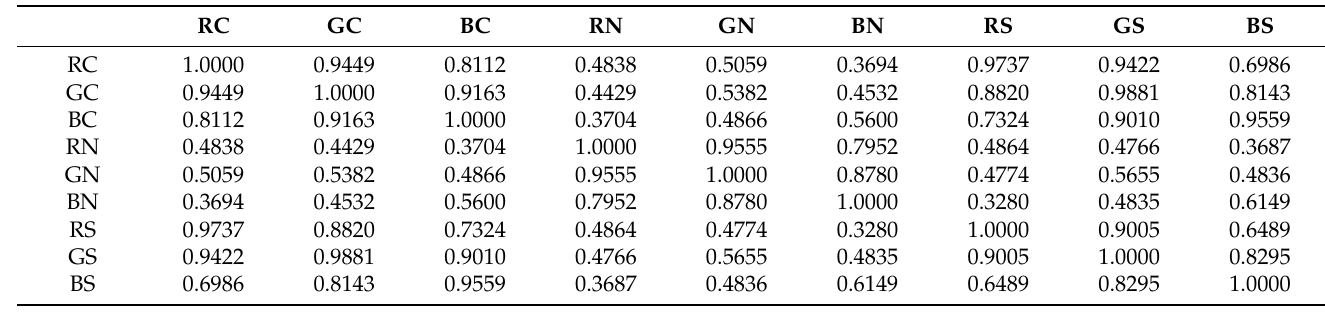
B S correspond to the RGB values for Samsung, respectively.